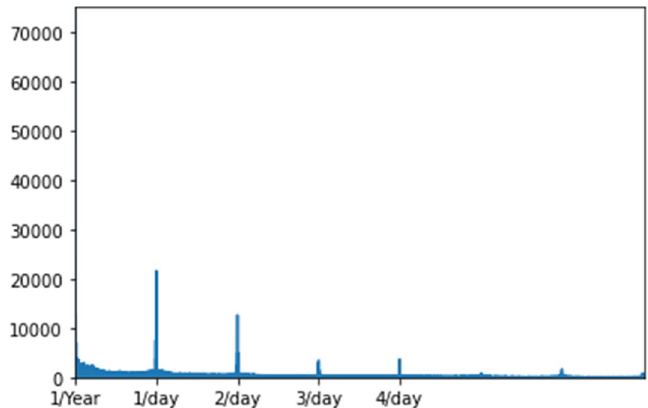
Fig. 20 Sub-area wind speed